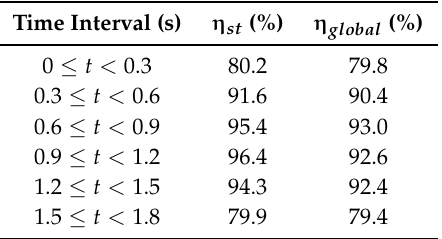
Table 9. Efficiencies calculated in the V2G